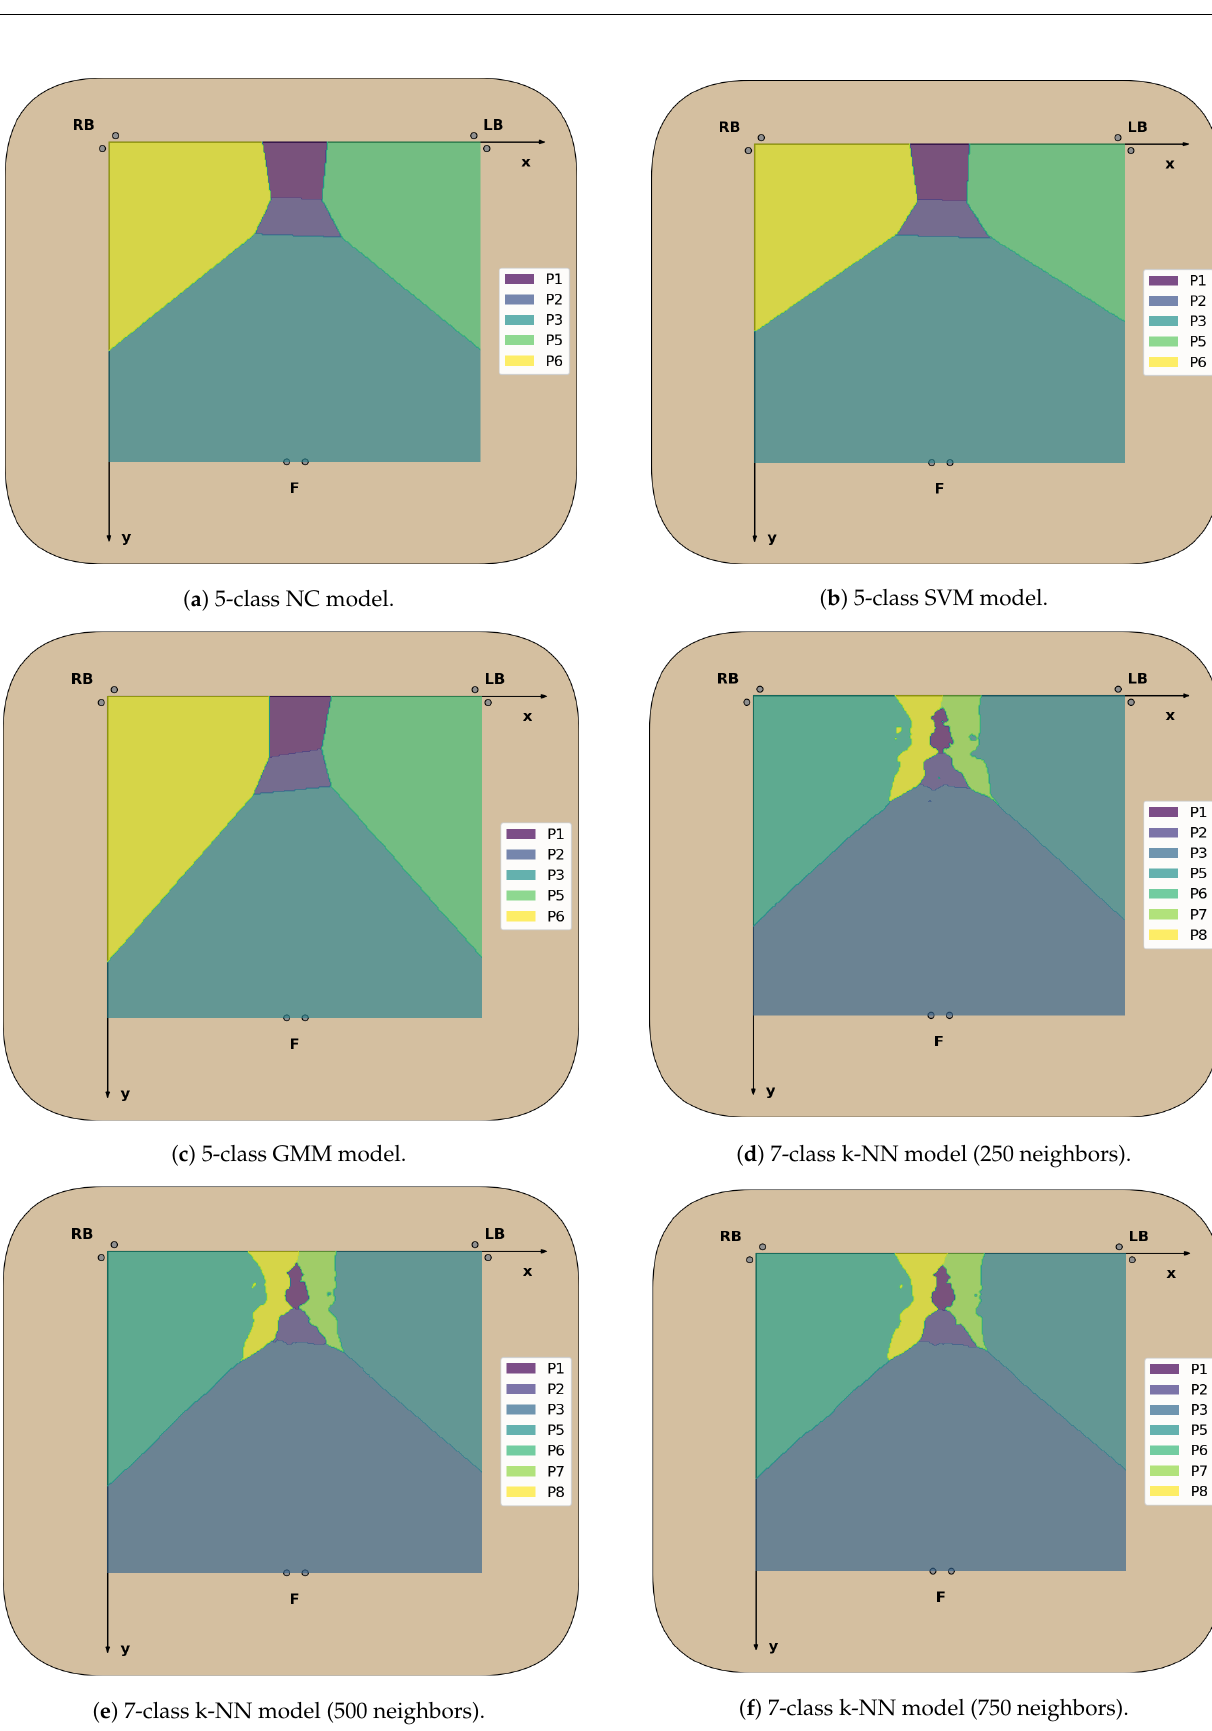
Figure A8. Decision boundaries in the 2D chair seat plane for each classifier trained